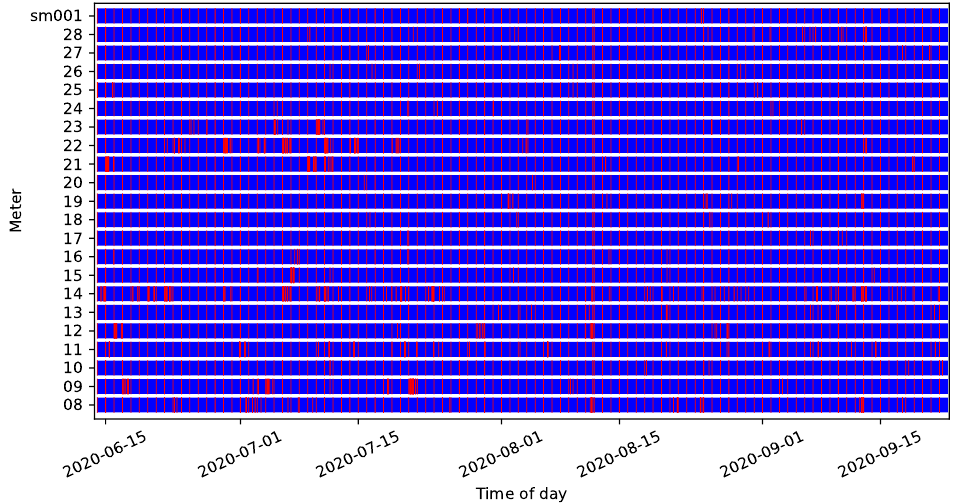
Figure 14. Time periods when measurement data are available. Each individual meter is shown on the y -axis (ID 08-28) while the time period of the complete recording is shown on the x -axis. Red areas indicate gaps in the dataset. Please note that gaps are plotted with at least one pixel width for better visibility and therewith appear significantly